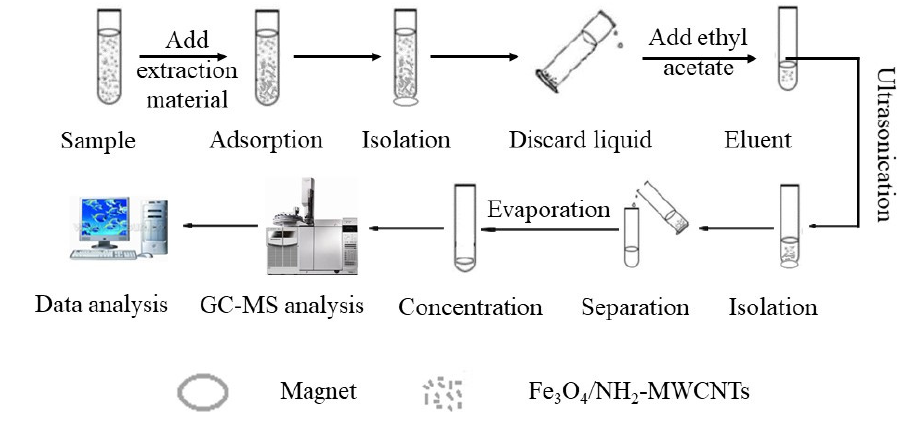
Figure 1. Schematic procedure for MSPE and the analysis of 16 kinds of synthetic cathinones in human urine with GC-MS.